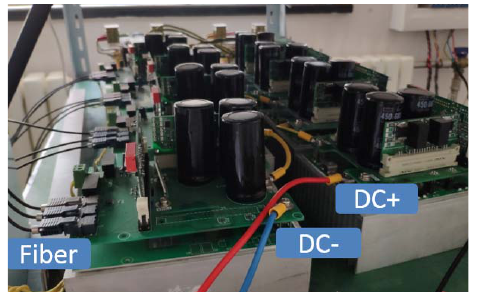
Figure 8. Laboratory prototype. Table 1. MMC